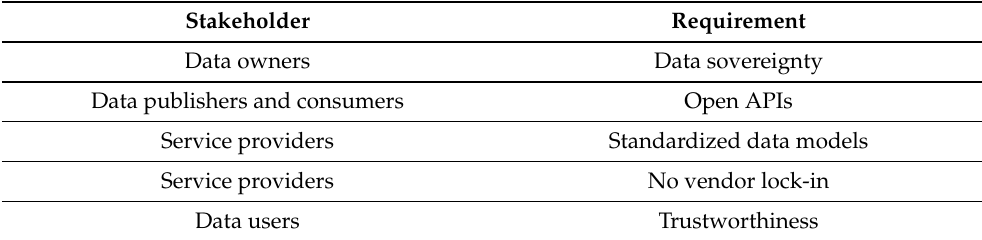
Table 1. Main stakeholder requirements in a big data